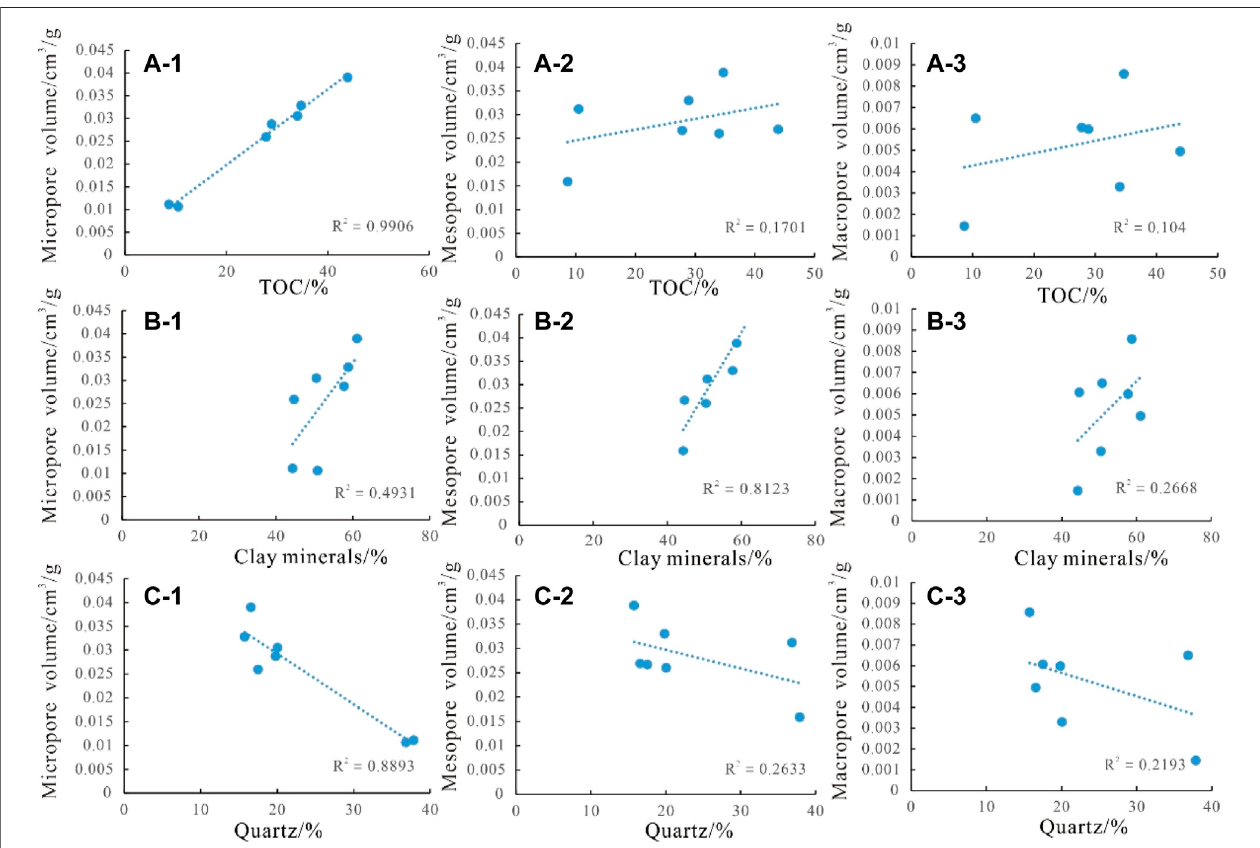
FIGURE5| Correlationofmainshalecomponentswithmicropores,mesopores,andmacroporesforShan 23 shale[ (A) TOCcorrelationwithmicropore,mesopore, and macropore volumes; (B) clay minerals correlation with micropore, mesopore, and macropore volumes; (C) quartz correlation with micropore, mesopore, and macropore